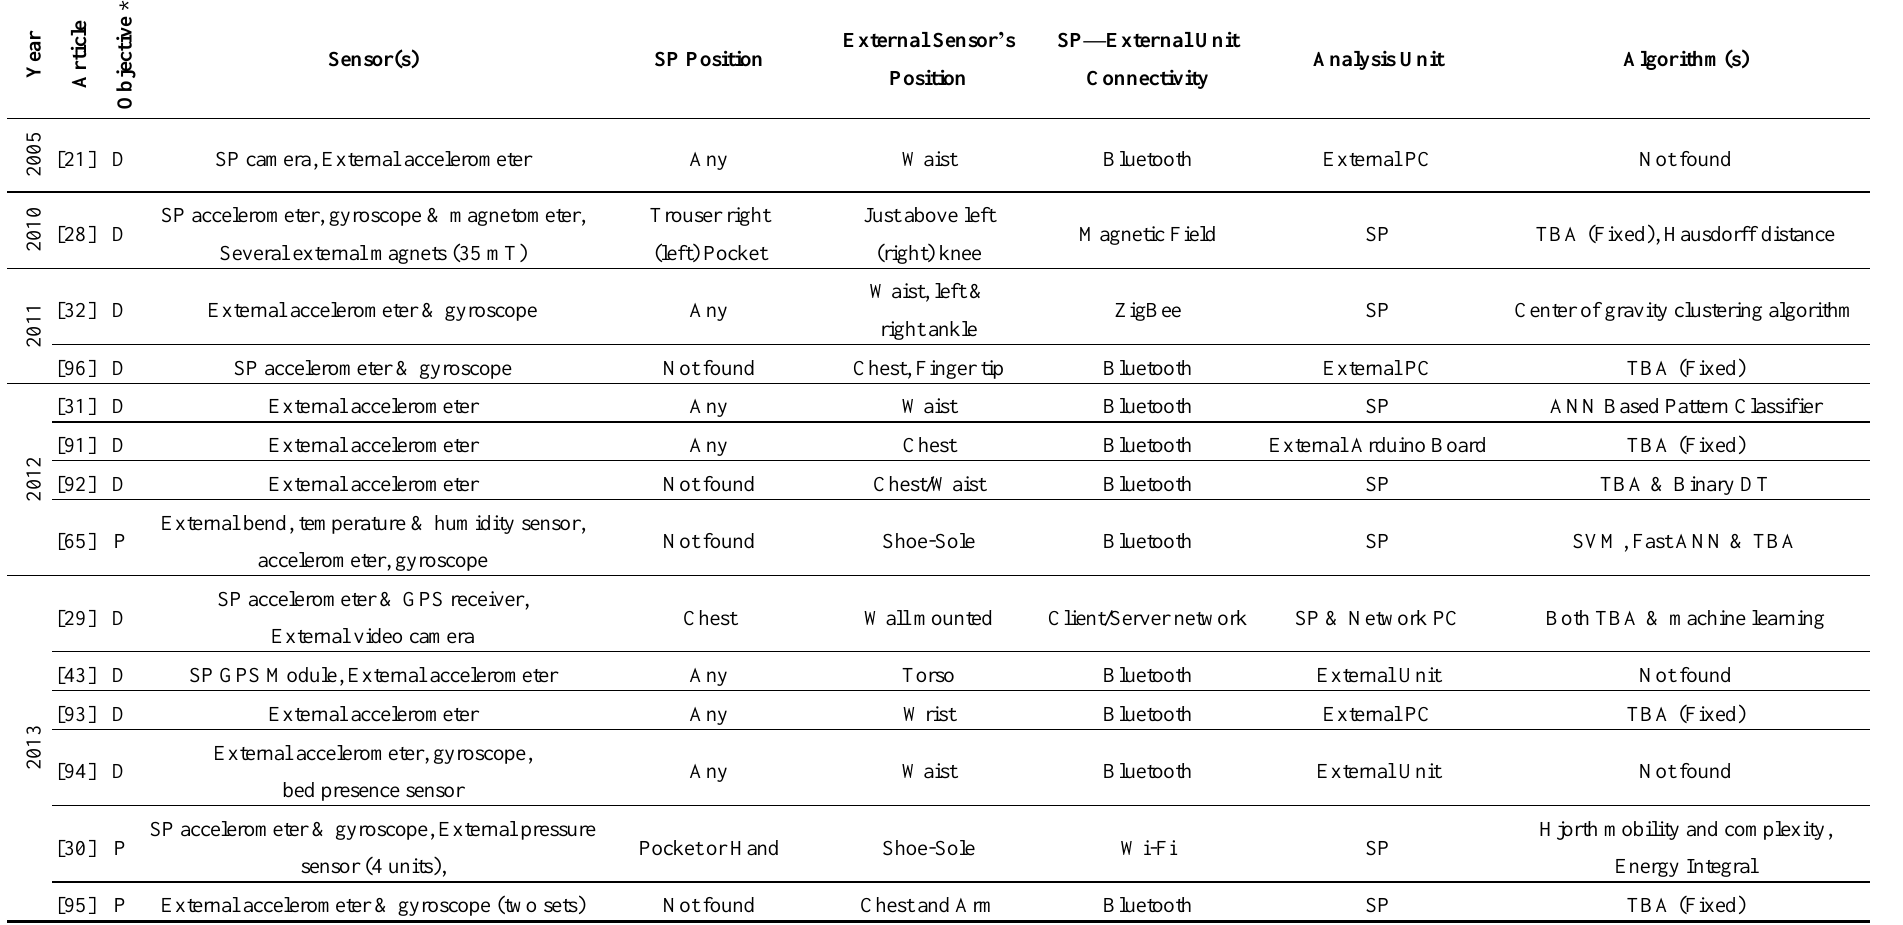
Table 4. Fall detection and prevention systems using smartphone and other external